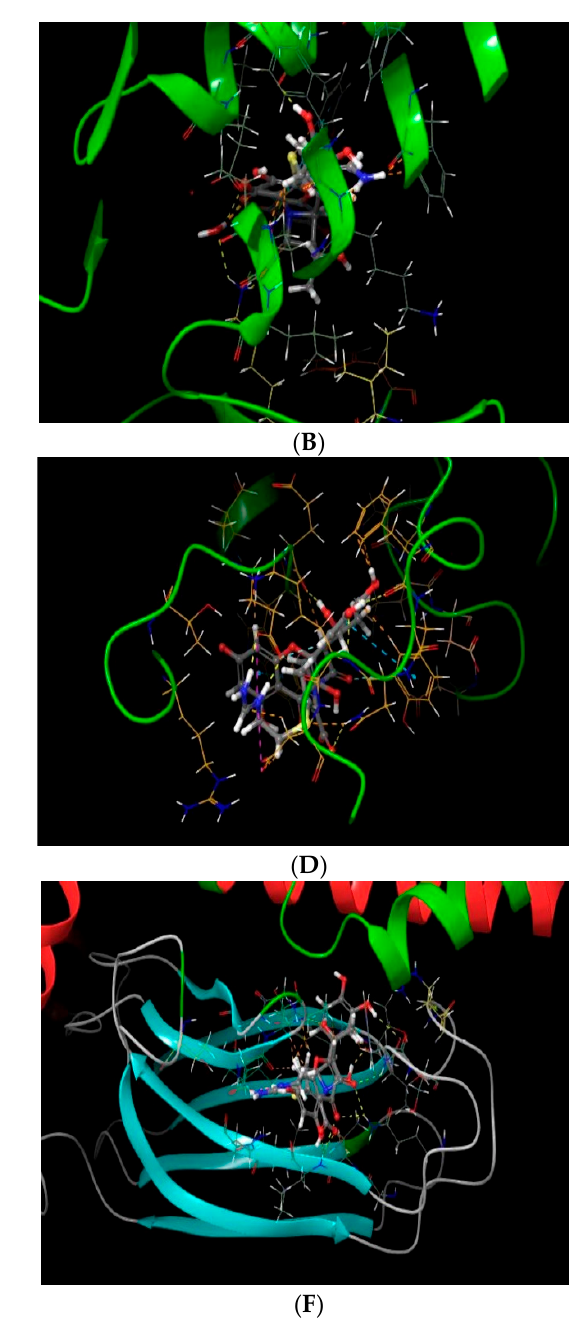
Figure 4. ( A ) Superimposing image of quercetin and cyclophosphamide at the active binding site of surfactant protein D (PDB ID: 1PW9). ( B ) Superimposing image of quercetin and imipenem at the active binding site of surfactant protein D (PDB ID: 1PW9). ( C ) Superimposing image of quercetin and cyclophosphamide at the active binding site of lactobacillus bacterial protein (4MKS). ( D ) Superimposing image of quercetin and imipenem at the active binding site of lactobacillus bacterial protein (4MKS). ( E ) Superimposing image of quercetin and cyclophosphamide at the active binding site of heat shock protein (PDB ID: 4PO2). ( F ) Superimposing image of quercetin and imipenem at the active binding site of heat shock protein (PDB ID: 4PO2).